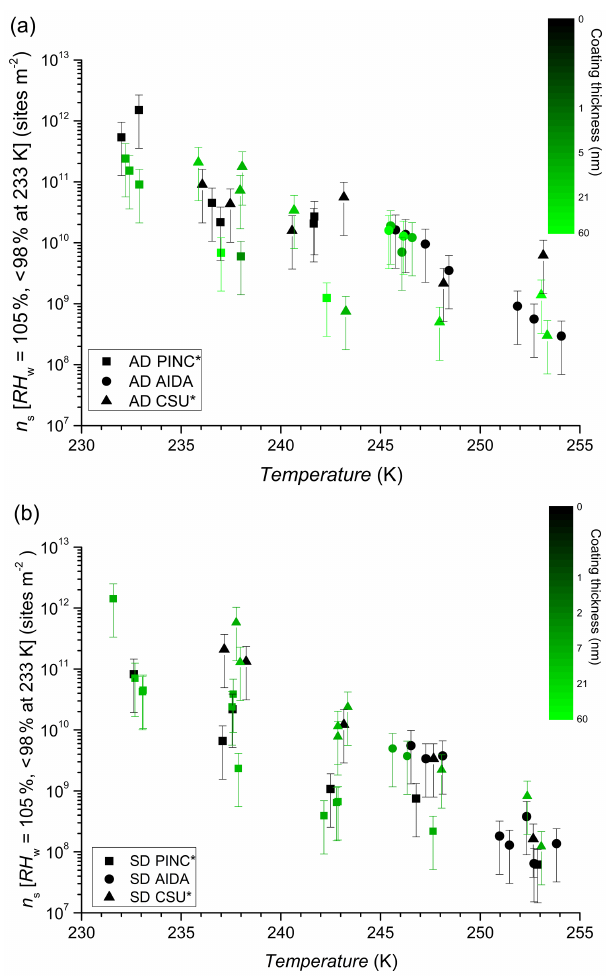
Figure 6. INAS densities as a function of temperature and SOA coat- ing thickness for AD (a) and SD (b) . Black symbols represent un- coated dust. Error bars are based on 75% sizing due to spherical assumption and surface area determination and 15% from particle counting resulting in a relative error of 77% in INAS density . The asterisk ( ∗ ) denotes that PINC and CSU-CFDC data have been ad- justed by a factor of 3 (see text Sect. 4 for